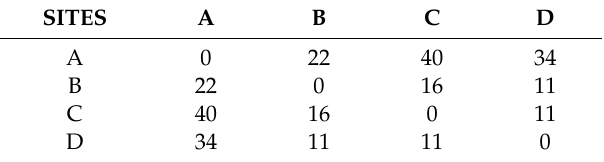
Table 2. Distance matrix among four of the university campuses (sites) in kilometers